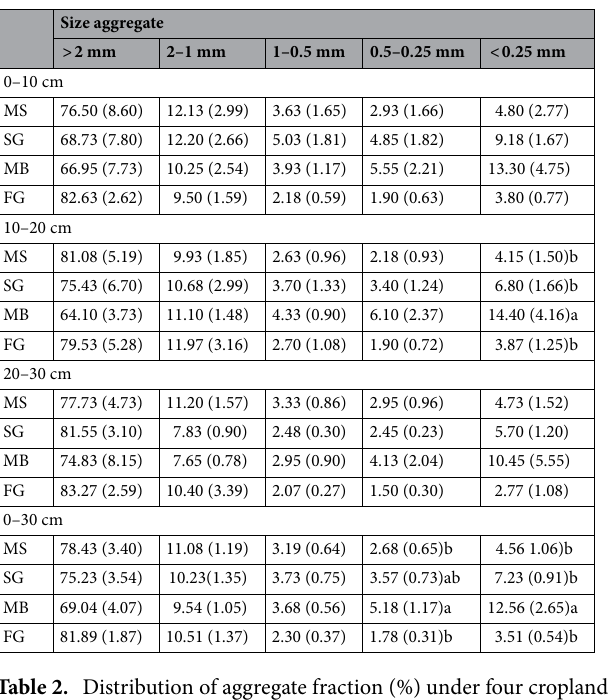
Table 2. Distribution of aggregate fraction (%) under four cropland use types. Data are presented by means with standard error. Different letters indicate significant difference among four cropland use types at p < 0.05.